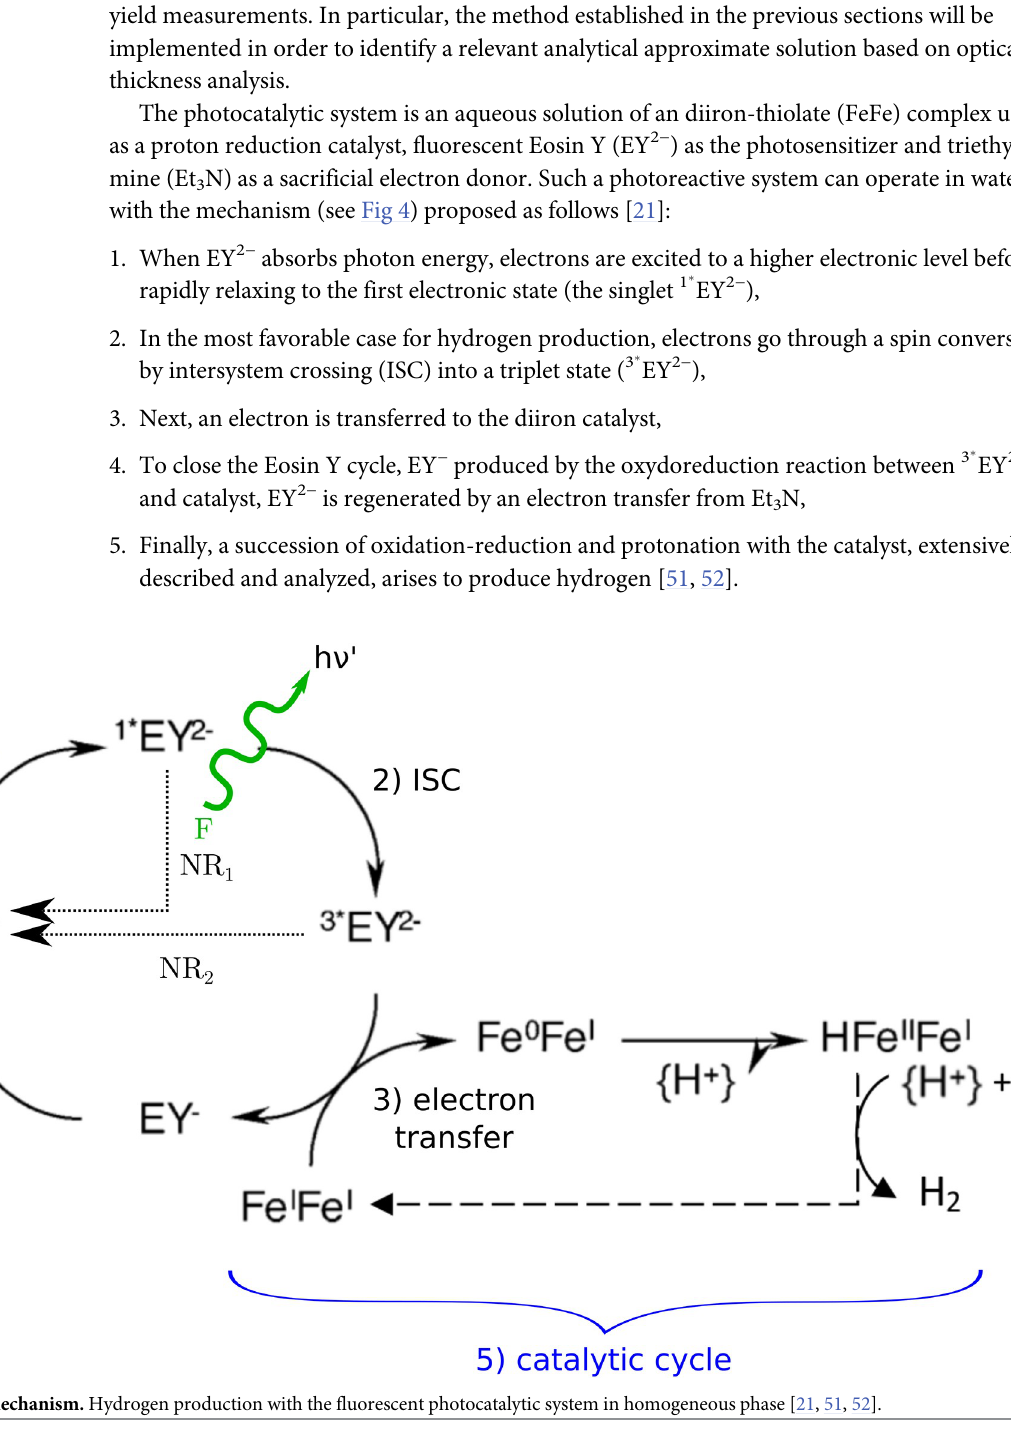
PLOS ONE | https://doi.org/10.1371/journal.pone.0255002 July 22,